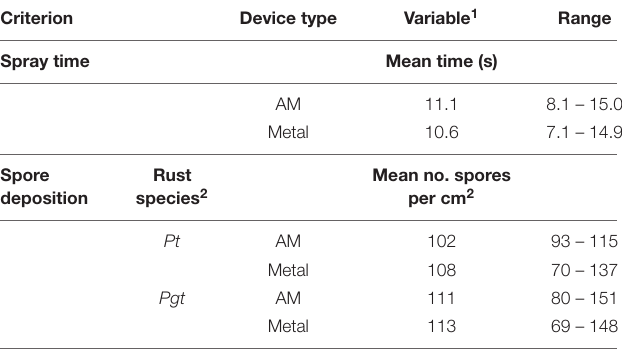
TABLE 1 | Spray delivery time of and urediniospore deposition by inoculation devices produced by Additive Manufacturing (AM) in comparison with traditionally manufactured metal inoculators.